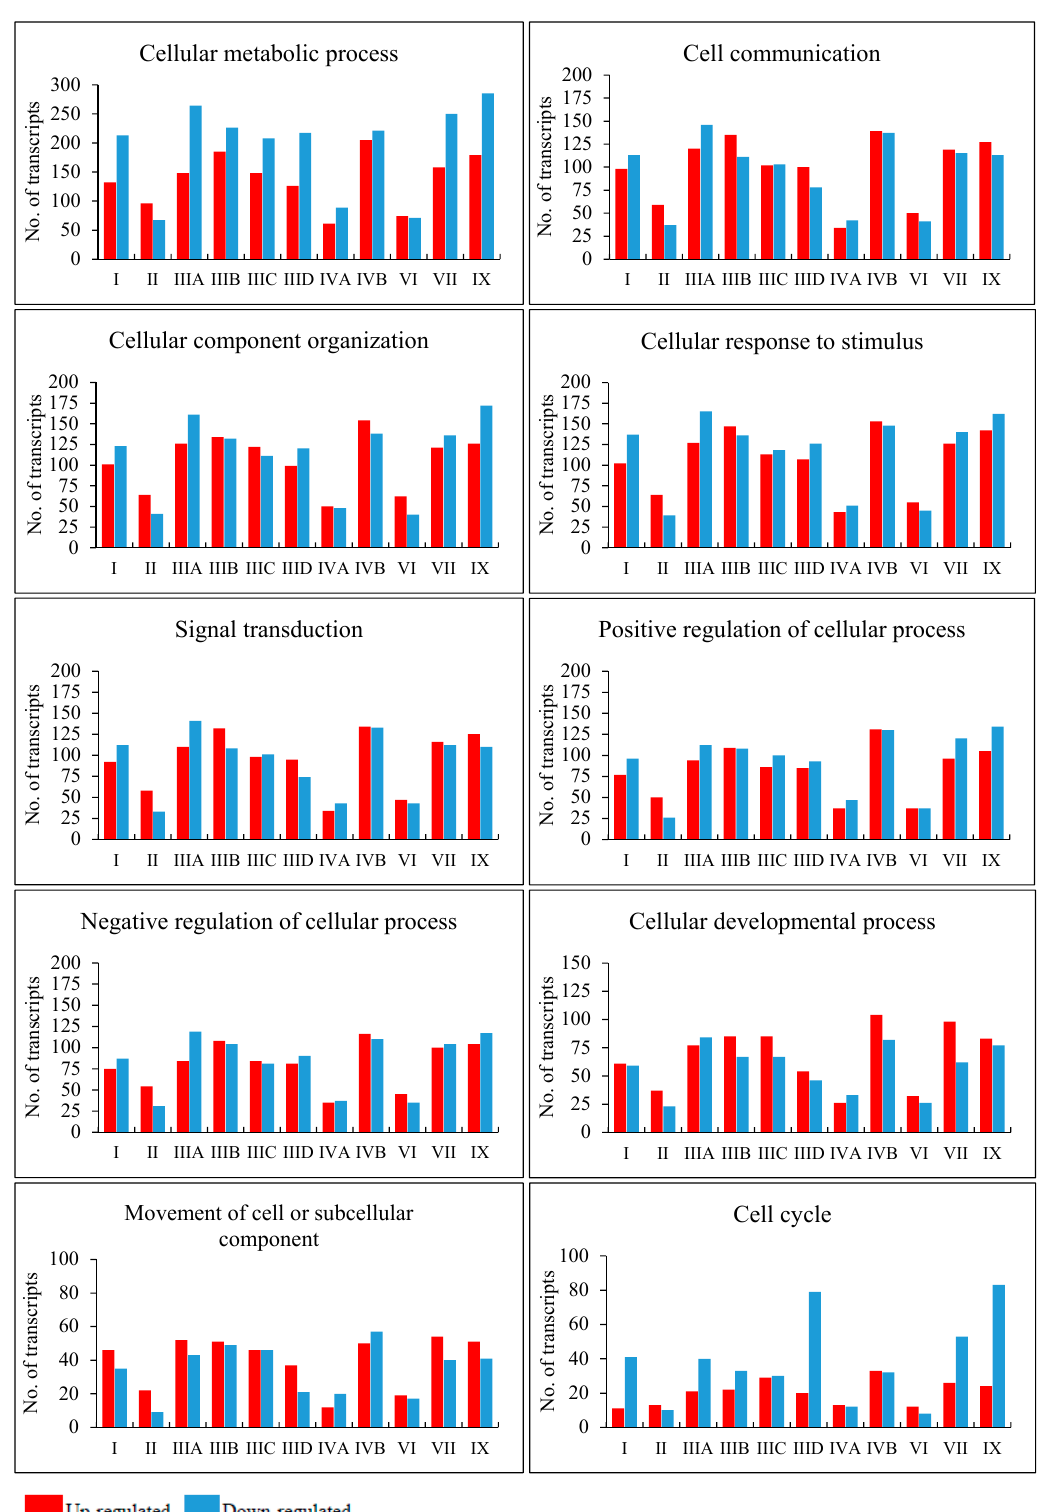
Figure 2. Number of up- and down-regulated transcripts (at FDR < 0.1; p < 0.1) with division into selected cellular processes in di ff erent MPS types relative to control cells (HDFa).